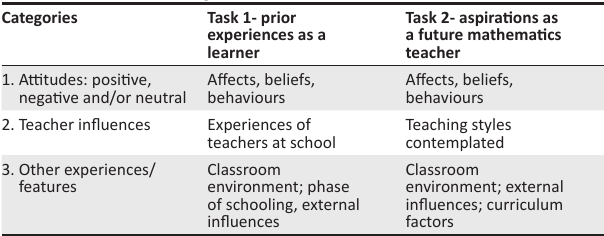
TABLE 2: Pre-selected